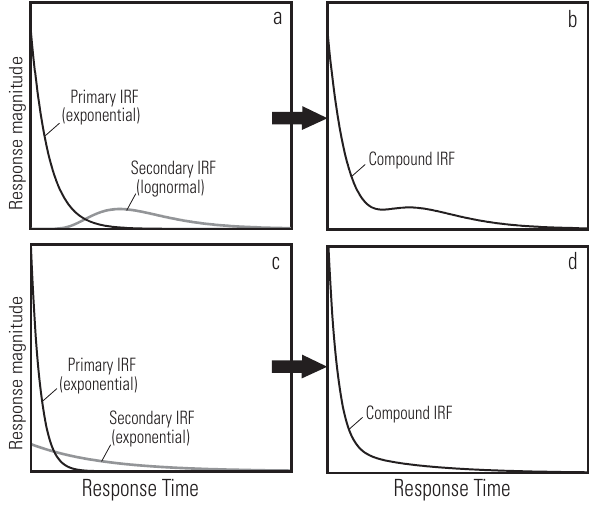
Fig. 1. Examples of compound impulse-response functions (IRFs) consisting of the superposition of an exponential and a lognormal curve ( a and b ) and two exponential curves ( c and d ).